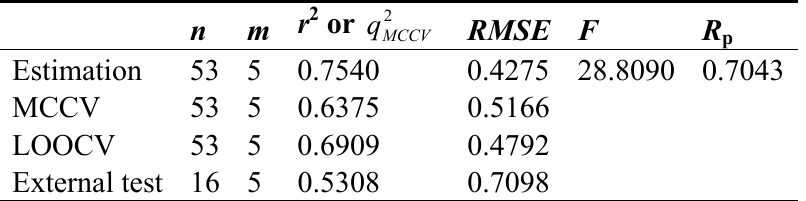
Table 2. Some statistic parameters of the